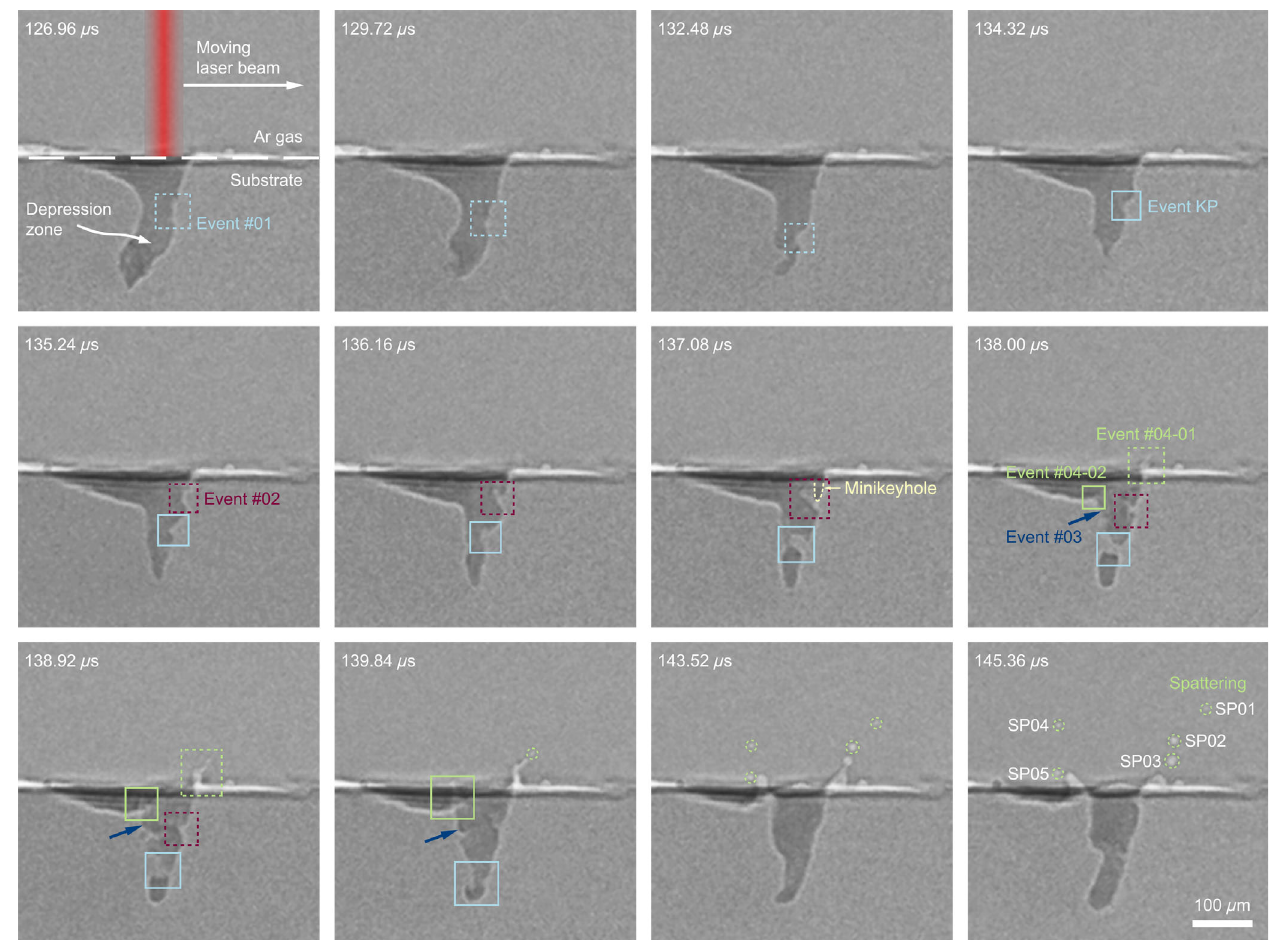
FIG. 1. MHz x-ray images of metal spattering of Ti-6Al-4V during laser processing. Four events can be extracted. Event no. 01 (sky blue dashed rectangles): A protrusion forms at the top surface and runs down along the front keyhole wall, accompanied by the keyhole morphology changing from a J -like shape to a reverse-triangle-like shape. Event no. 02 (purple dashed rectangles): A following protrusion appears, grows, and collapses around the horizontal center of the keyhole. A minikeyhole on top of the protrusion is outlined by a light yellow dashed curve. Event no. 03 (dark blue arrows): The local curvature on the rear keyhole wall changes. Event no. 04 (light green dashed and solid rectangles): Melt ligaments form, elongate, and break up into spatters (light green dashed circles numbered SP01 – SP05). A separate event KP (sky blue solid rectangles) describes the formation and vanishing of a keyhole pore. The laser beam scans from left to right, with spot size of approximately 80 μ m ( 1 =e 2 ), power of 210 W, and scanning speed of 500 mm = s. The imaging frame rate is 1 . 087 × 10 6 frames per second, synchronized with the x-ray pulses. Each individual image is generated by a single x-ray pulse (pulse width approximately 100 ps). All images shown here are background corrected using the images collected before the laser melting. The contrast is then reversed to highlight the events around the keyhole. Frame-by-frame images as well as schematic illustrations are documented in the Supplemental Material Figs. S3 and S4 and Video S2 pore. When the protrusion near the keyhole bottom from the front keyhole wall collides with the rear keyhole wall, the closure of the melt traps a pore at the keyhole bottom.